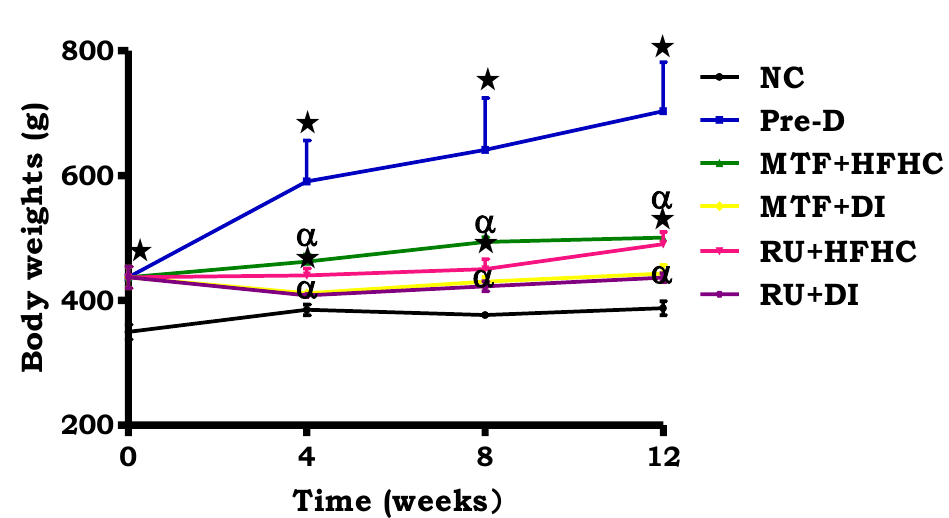
Figure 1. The effects of the ruthenium complex on body weight of pre-diabetic animals during treatment period. Values are presented as means ± SEM ( n = 6) in each group. * p < 0.05 by comparison with normal control (NC), α p < 0.05 by comparison with pre-diabetic control (Pre-D); Metformin and high fat high carbohydrate (MTF + HFHC); Metformin and diet intervention (MTF + DI); Ruthenium and high fat high carbohydrate (RU + MTF); and Ruthenium and diet intervention (RU + DI).